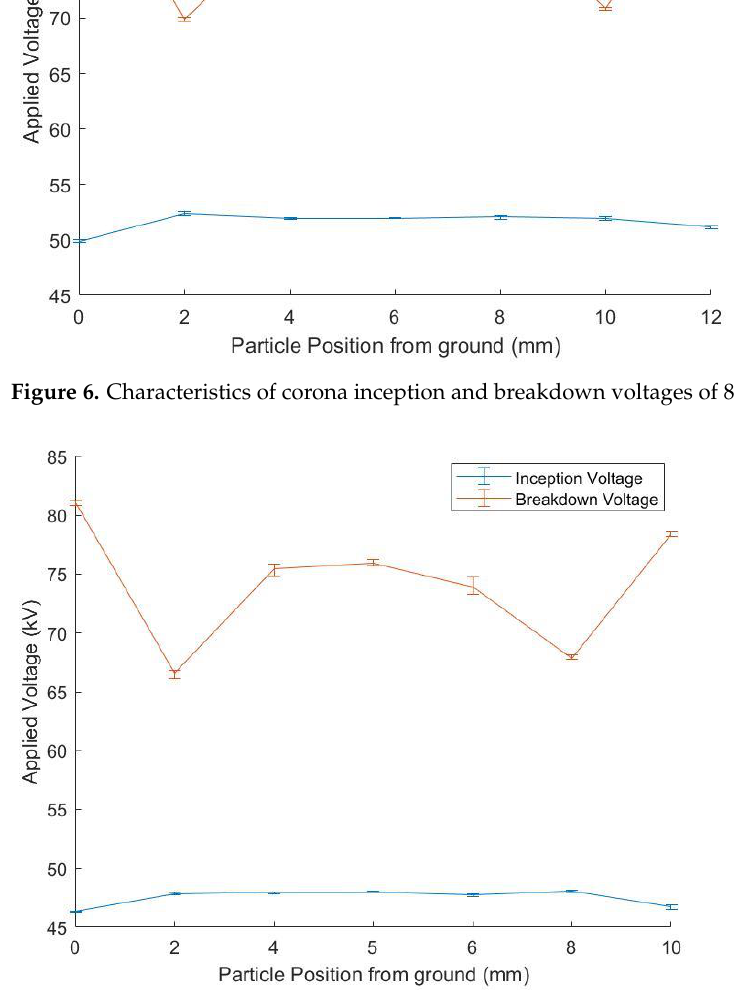
Figure 7. Characteristics of corona inception and breakdown voltages of 10 mm of unsymmetrical particle.